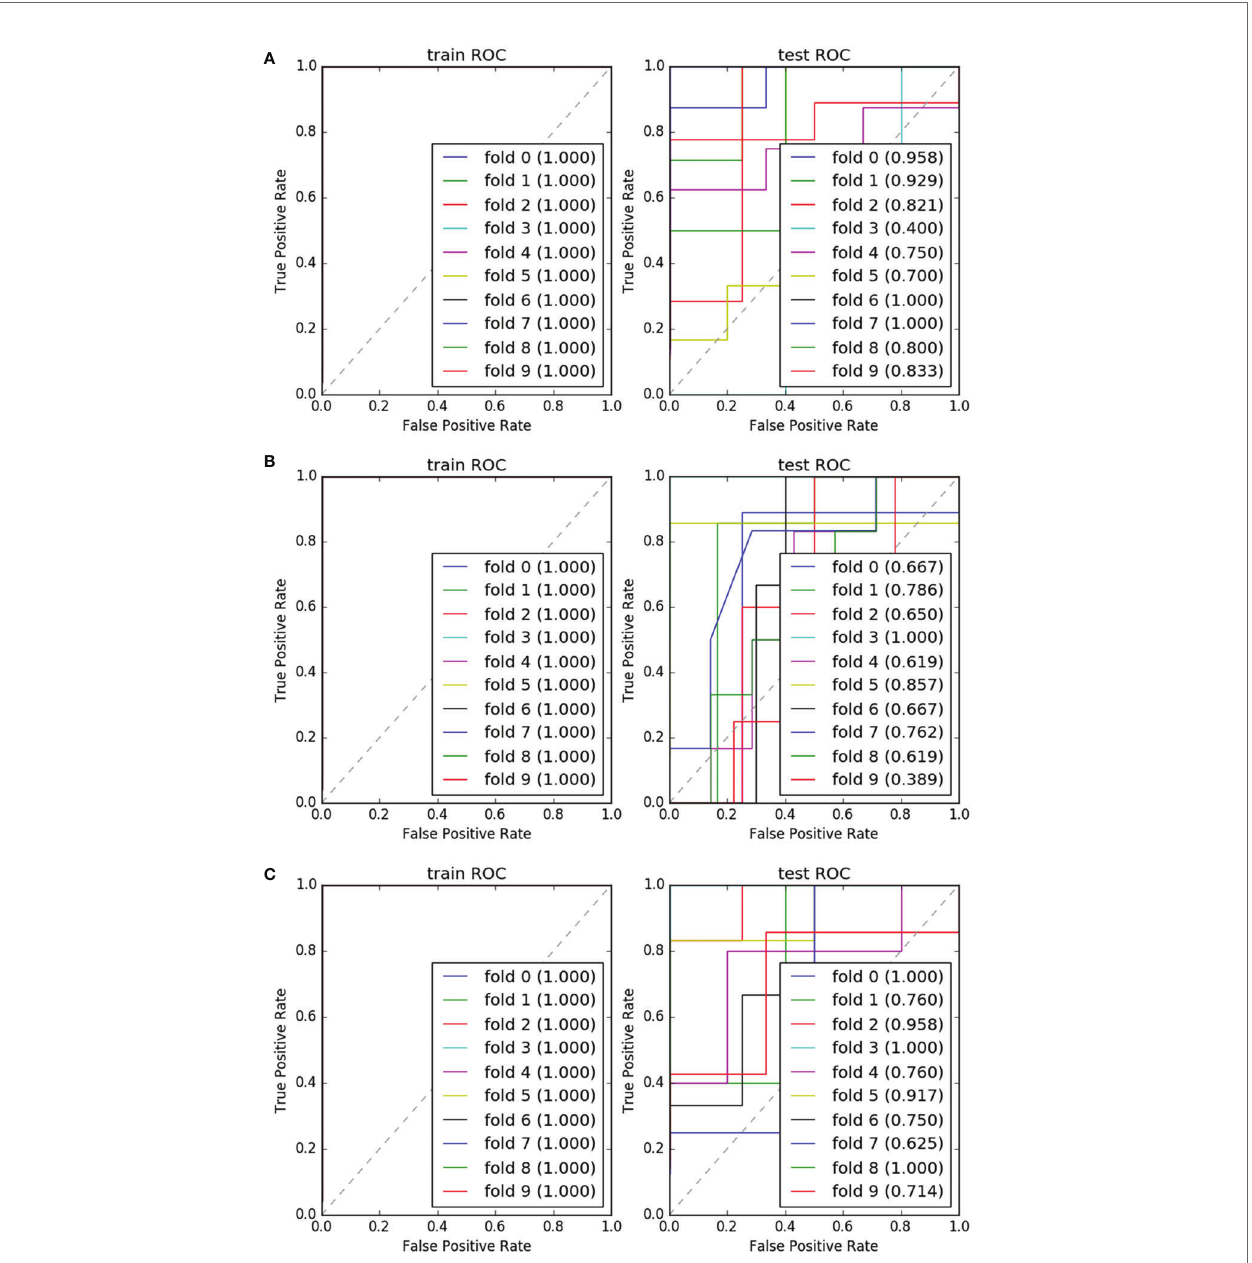
FIGURE 4 | The ROC and AUC results of 10 fold of “ DC+AdaBoost ” in training set and validation set. G1 vs G2 (A) ; G2 vs G3 (B) ; G1 vs G3 (C)